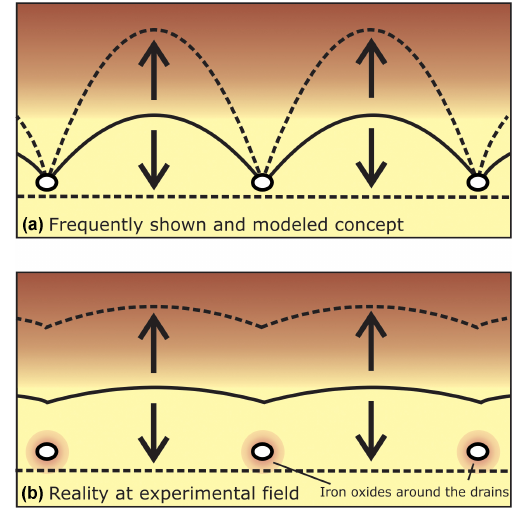
Figure 9. Comparison of (a) the common drainage concept with groundwater tables at the drain elevations and a large groundwa- ter curvature between individual drains and (b) the situation at the experimental field with groundwater tables above the drains and a small groundwater curvature between the drains.